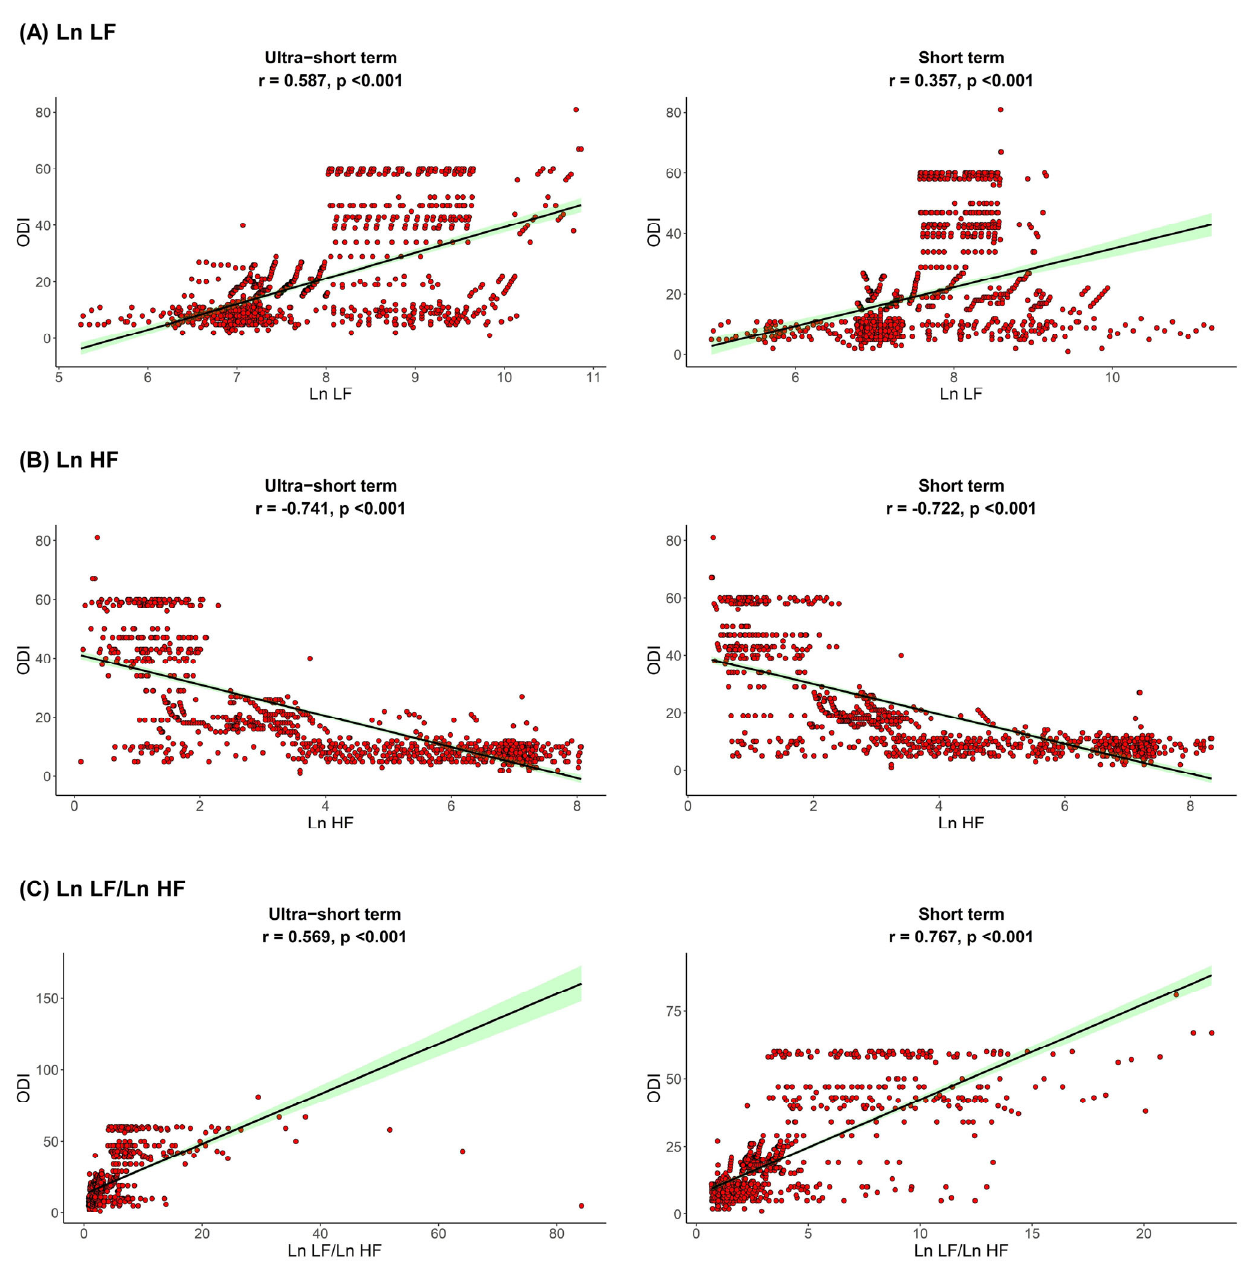
Figure 2. Correlation between ODI and ( A ) Ln LF, ( B ) Ln HF, ( C ) Ln LF/Ln HF. Oxygen desaturation index, ODI; total power, Ln TP; very low frequency, Ln VLF; low frequency, Ln LF; high frequency, Ln HF. Ln